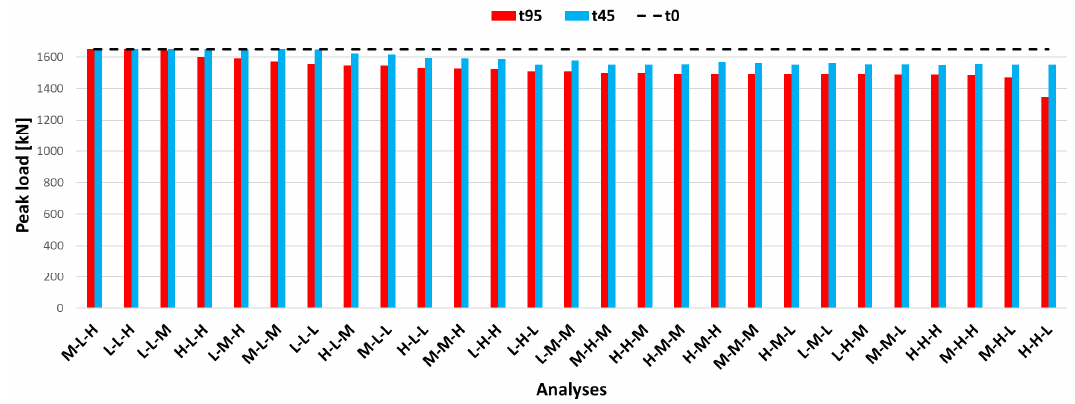
Figure 20. Load-carrying capacity of the saddle as a function of chloride parameter combination.